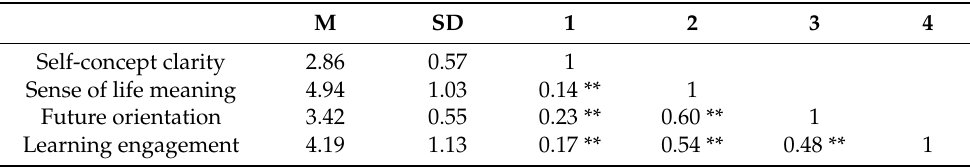
Table 1. Descriptive statistics and correlation among variables ( n = 997). M SD 1 2 3 4 Self-concept clarity 2.86 0.57 1 Sense of life meaning 4.94 1.03 0.14 ** 1 Future orientation 3.42 0.55 0.23 ** 0.60 ** 1 Learning engagement 4.19 1.13 0.17